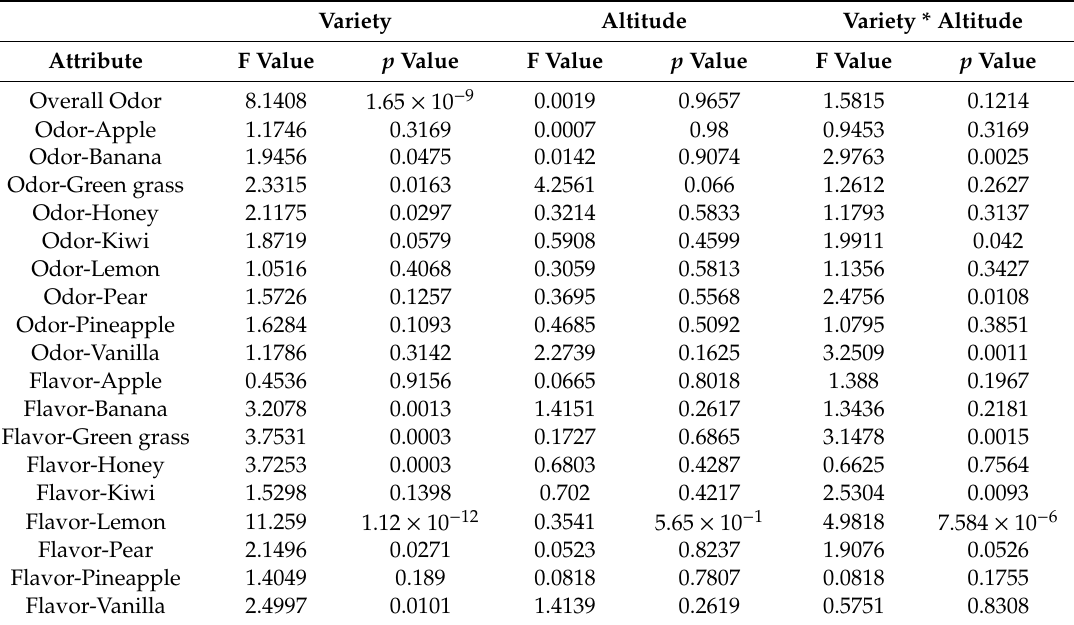
Table 1. p values from two-way ANOVA on sensory data, considering variety and altitude as